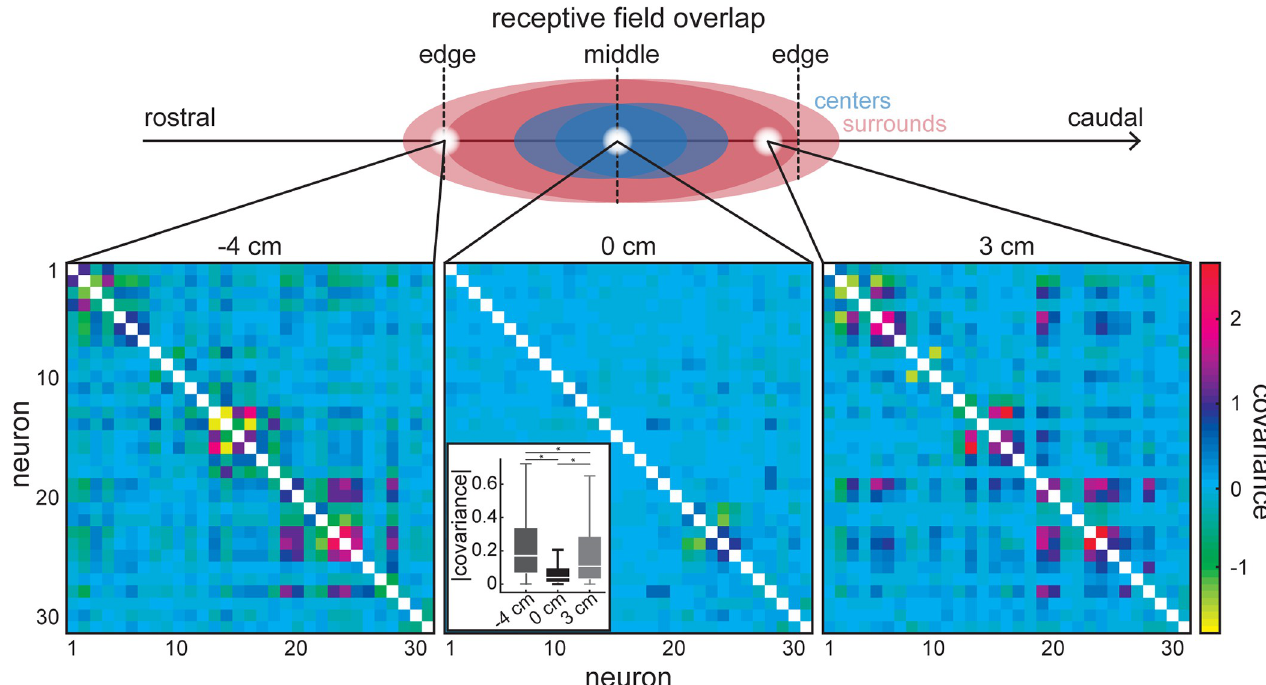
Fig 4. ELL pyramidal cells display spatially dependent covariance. Covariance matrices (bottom panels) obtained for three different positions (top; receptive field schematic for two overlapping neurons: centers in blue, surrounds in red). Pairwise covariances at stimulus positions near the edges of where the receptive fields overlap (left and right panels), where the surrounds of most neurons are activated, are larger than in the middle of the receptive field overlap (center panel), where the centers of most neurons are activated. (Note: the variances along the diagonal are not shown to emphasize the spatial dependence of the covariances.) Center inset: The distribution of covariance magnitudes is significantly different across the three stimulus positions (Kruskal-Wallis: p = 1.4 � 10 − 52 ; left-center: p = 3.5 � 10 − 51 ; left-right p = 4.8 � 10 − 6 ; center-right p = 1.7 � 10 − 24 ). “ � ” indicates statistical significance.